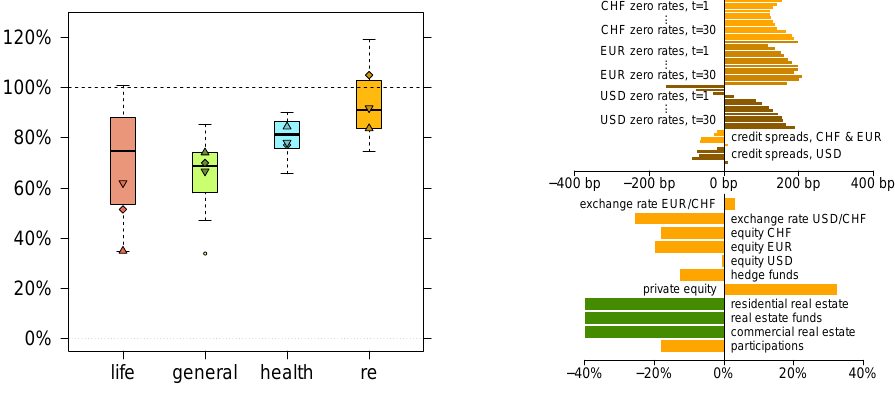
Figure 7. (rhs) illustrates the changes in market risk factors due to a real estate market crash. The changes colored green are predefined, the changes colored orange result from market dependencies. (lhs) illustrates the resulting impact ratios (cid:36) i of the insurance companies, where (cid:78) , (cid:7) and (cid:72) correspond to the impact ratios of the first, second and third largest company, respectively, in each branch of